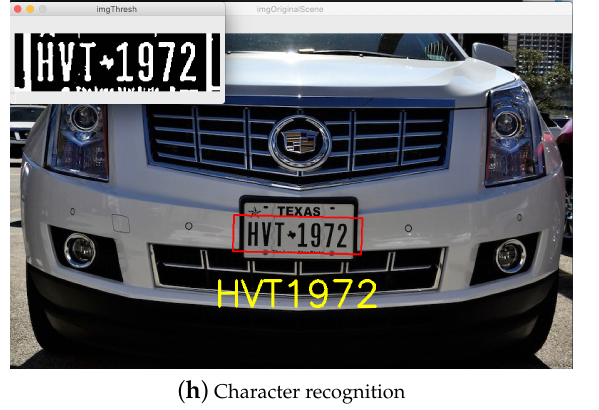
Figure 2. Phases of the plate detection, character segmentation, and recognition